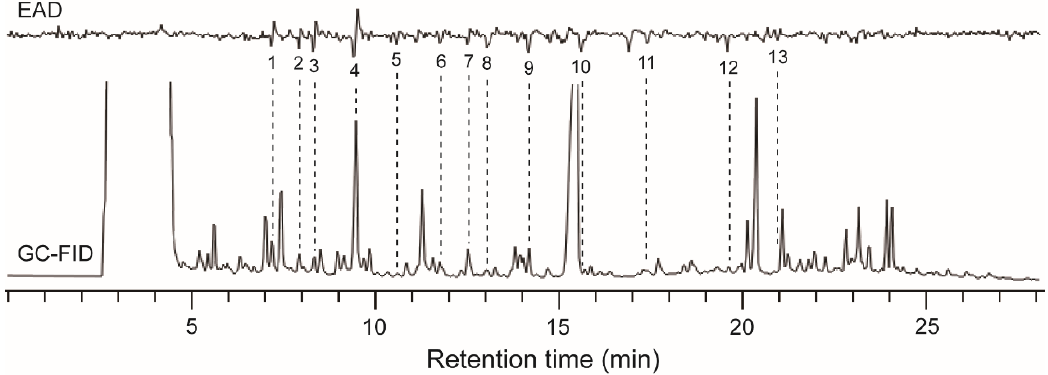
Figure 1. Gas chromatography-electroantennographic detection (GC-EAD) responses of female Drosophila suzukii to headspace volatile sample of Osyris wightiana fruits. The EAD-active compounds identified are listed in Table 1. Table 1. EAD-active compounds to female Drosophila suzukii emitted from ripe fruits of Osyris wightiana . Peak No. Peak